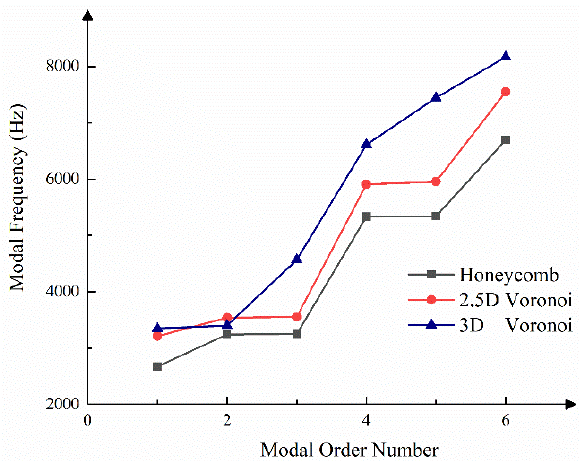
Figure 11. The front six modes and the corresponding frequency of the mirrors.